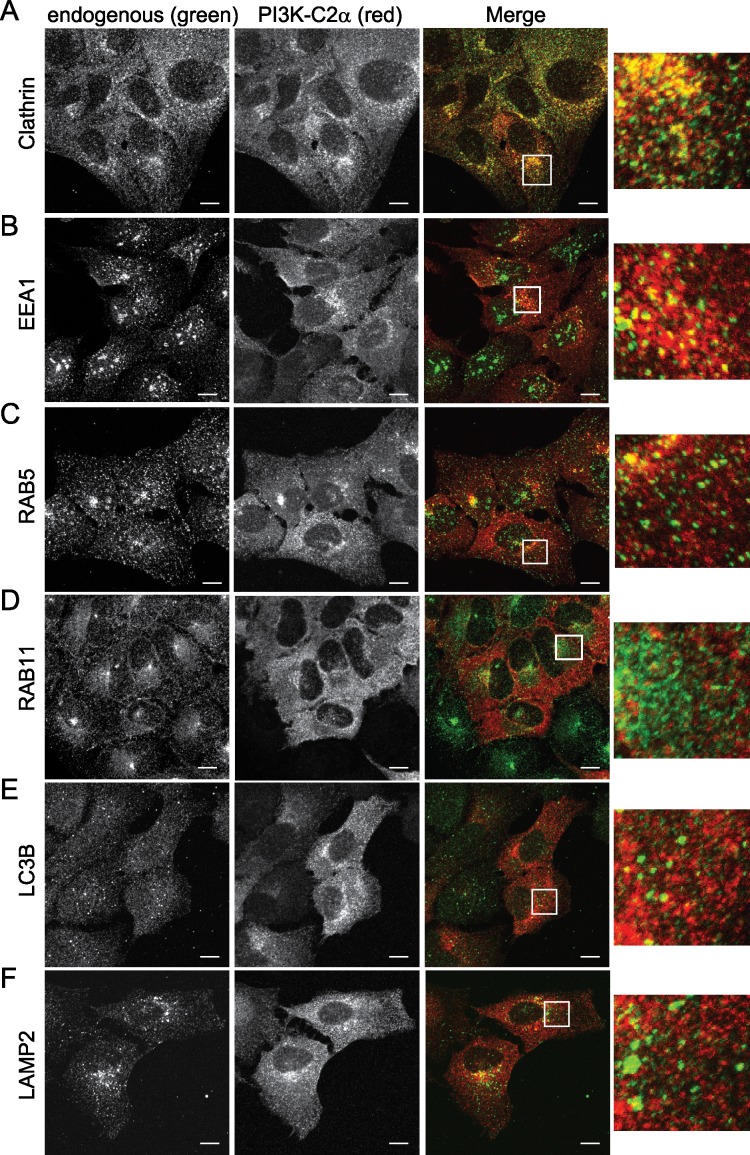
PI3K-C2α colocalizes with markers of early endocytosis.mCherry-PI3K-C2α expressing U2OS cell line was fixed and stained with primary antibodies against clathrin (A), EEA1 (B), RAB5 (C), RAB11 (D), LC3B (E), and LAMP2 (F). Secondary antibody (green) marks primary antibody staining. Cells were imaged with a 60× oil objective by confocal microscopy. Boxes are 5× magnifications of insets. Scale bar 10 μm.